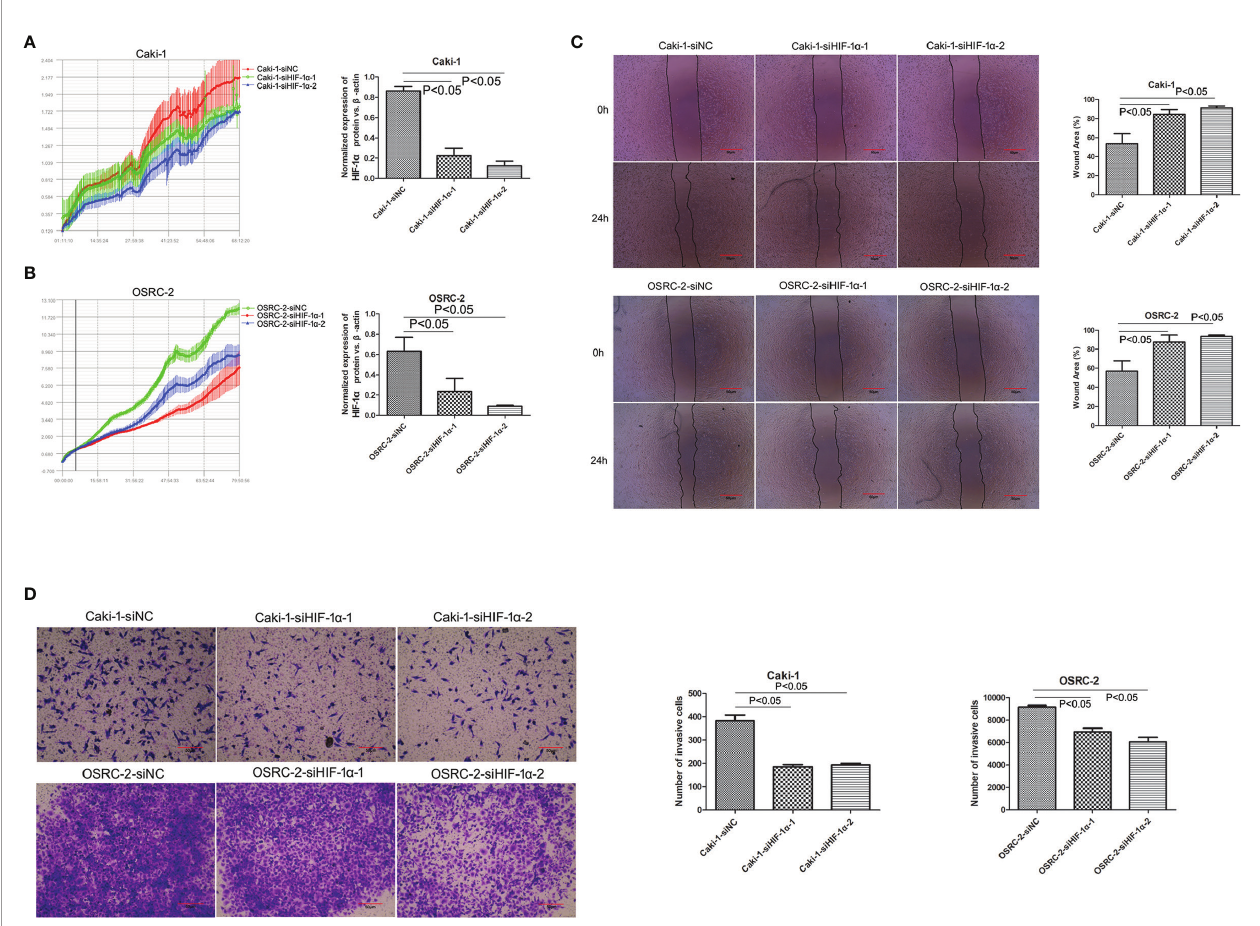
FIGURE 3 | Knockdown of HIF-1 a attenuated the effect on cellular proliferations, migrations and invasion (both Caki-1 and OSRC-2 cells). Downregulation of HIF- 1 a inhibited cell proliferation as shown by the RTCA results (P <0.05). (A) Red line: Caki-1-siNC, green line: Caki-1-siHIF-1 a -1, blue line: Caki-1-siHIF-1 a -2; (B) Green line: OSRC-2-siNC, red line: OSRC-2-siHIF-1 a -1, blue line: OSRC-2-siHIF-1 a -2. (C) Comparison of scratch width to verify the migratory capability of HIF- 1 a -siRNA-transfected cells and NC-siRNA-transfected cells. Knockdown of HIF-1 a sharply inhibited the migration of both Caki-1 and OSRC-2 cells (P <0.05). (D) Comparison of penetrability in Transwell chambers to verify the invasive capability of HIF-1 a -siRNA-transfected cells and NC-siRNA-transfected cells. Knockdown of HIF-1 a sharply suppressed the invasion of both Caki-1 and OSRC-2 cells (P